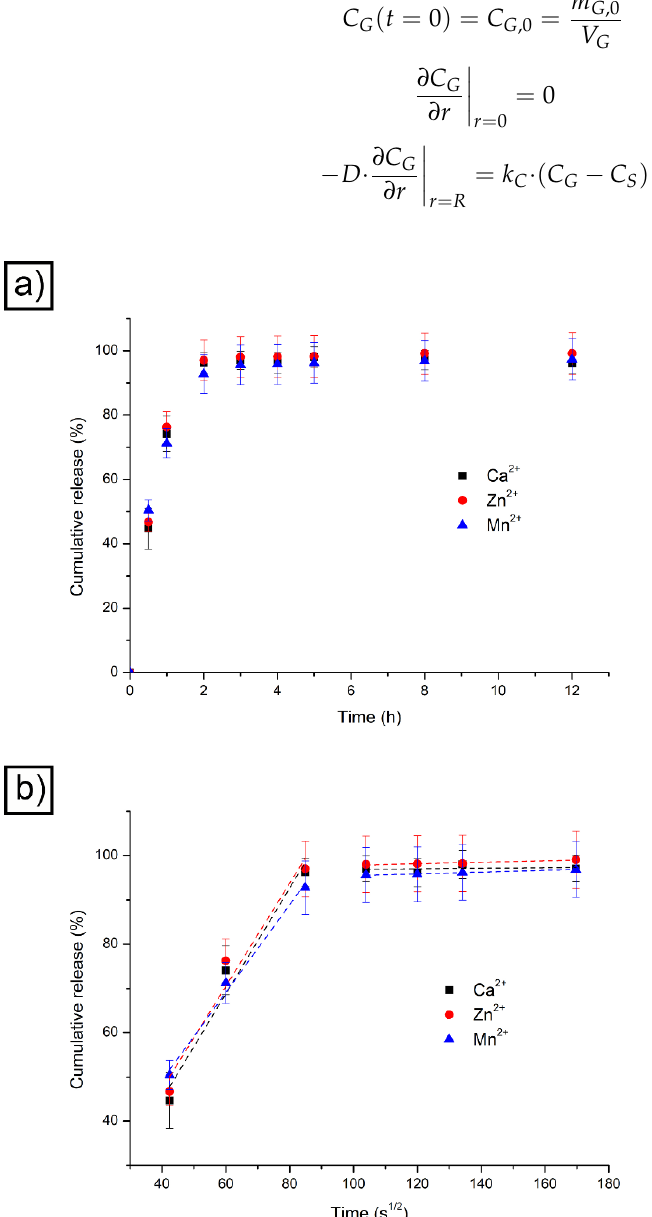
Figure 4. RhB release results obtained at 37 °C and pH 7.4 with different physical crosslinkers ( a ); RhB release results obtained at 37 °C and pH 7.4 with different physical crosslinkers plotted against time square root ( b ).